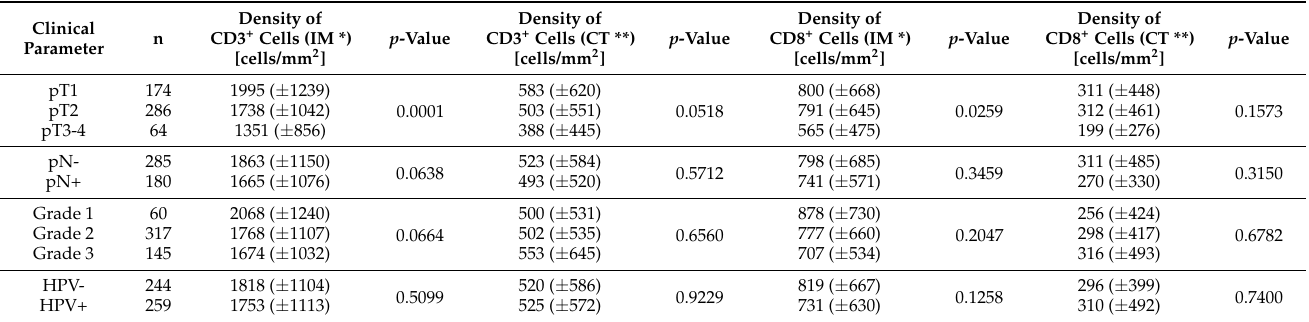
Table 1. Association between the density of CD3 + /CD8 + T-cells at the invasive margin/in the center of the tumor and vulvar cancer phenotype. ( ± Standard deviation).